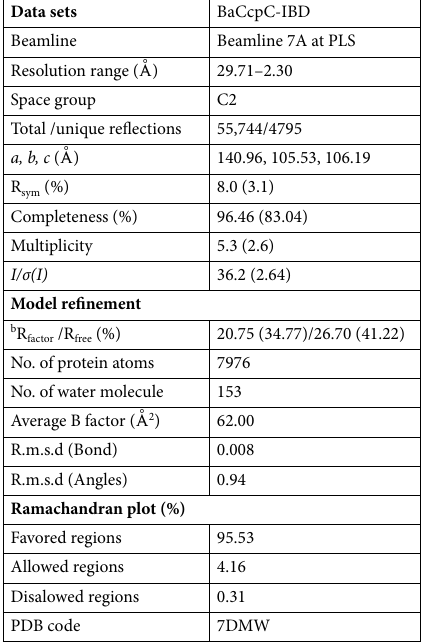
Table 1. Crystallography data and refinement statistics. a Values in the parentheses refers to the highest resolution shell. b ∑hkl │ Fo-Fc │ /∑hkl │ Fo │ for all data with Fo > 2σ(Fo), excluding data used to calculate Rfree. §Rfree = ∑hkl │ Fo-Fc │ /∑hkl │ Fo │ for all data with Fo > 2σ (Fo) that were excluded from